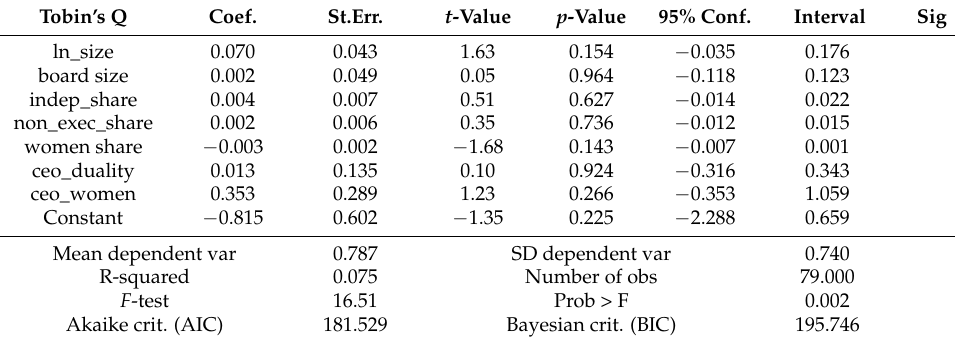
Table A4. Regression Model for Tobin’s Q.